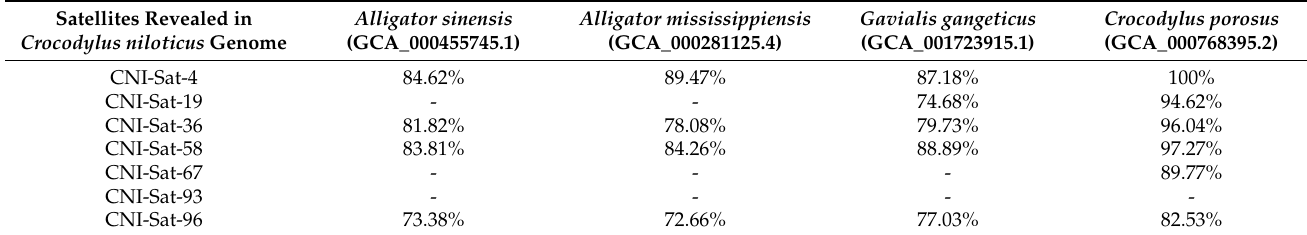
Table 2. Representation of satellite sequences in genome assemblies of four Crocodylia species. Percentage of identity for the best hit (obtained using blastn) shown for each